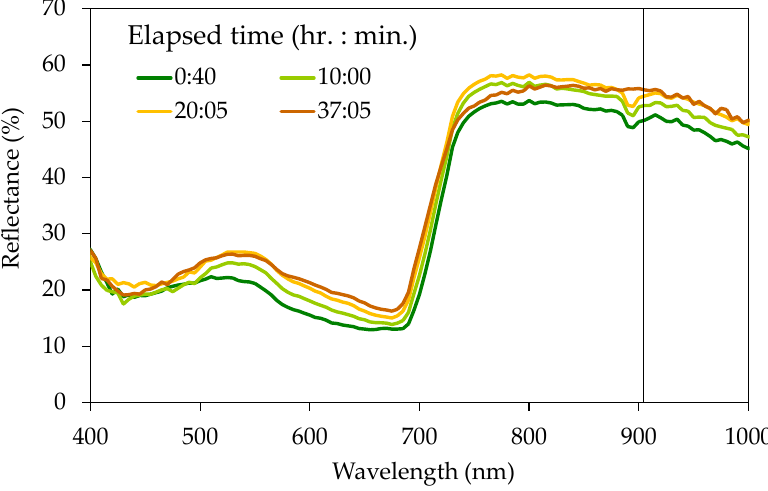
Figure 5. Changes in the reflection spectra of the sweet potato leaves with drying, as observed by the hyperspectral camera. The solid line denotes the LiDAR wavelength 905 nm.